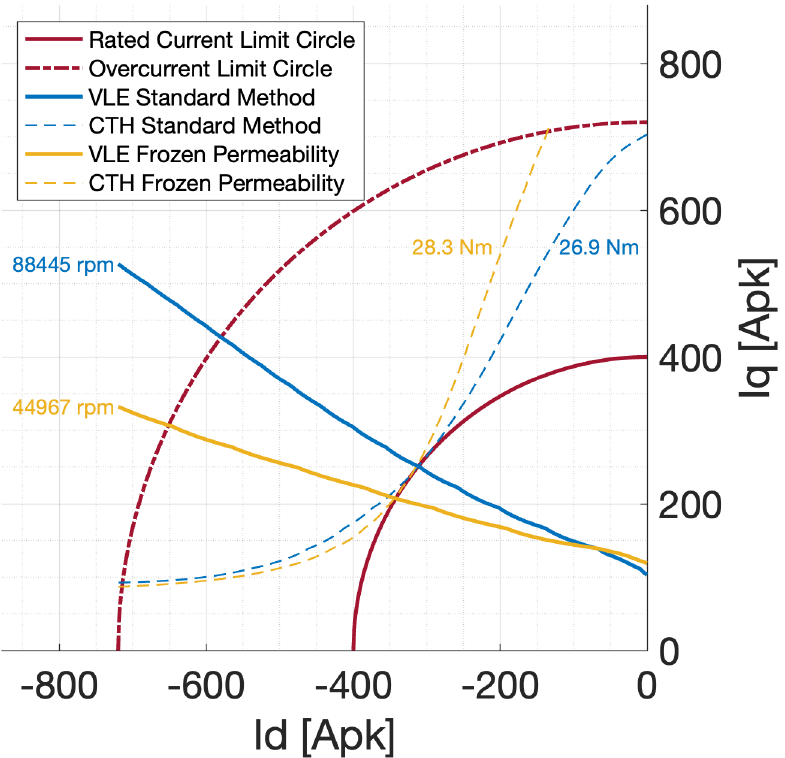
Figure 13. Comparison of Voltage Limit Ellipse (at base speed) and Constant Torque Hyperbola (at rated torque), obtained with Standard Method (blue) and FP